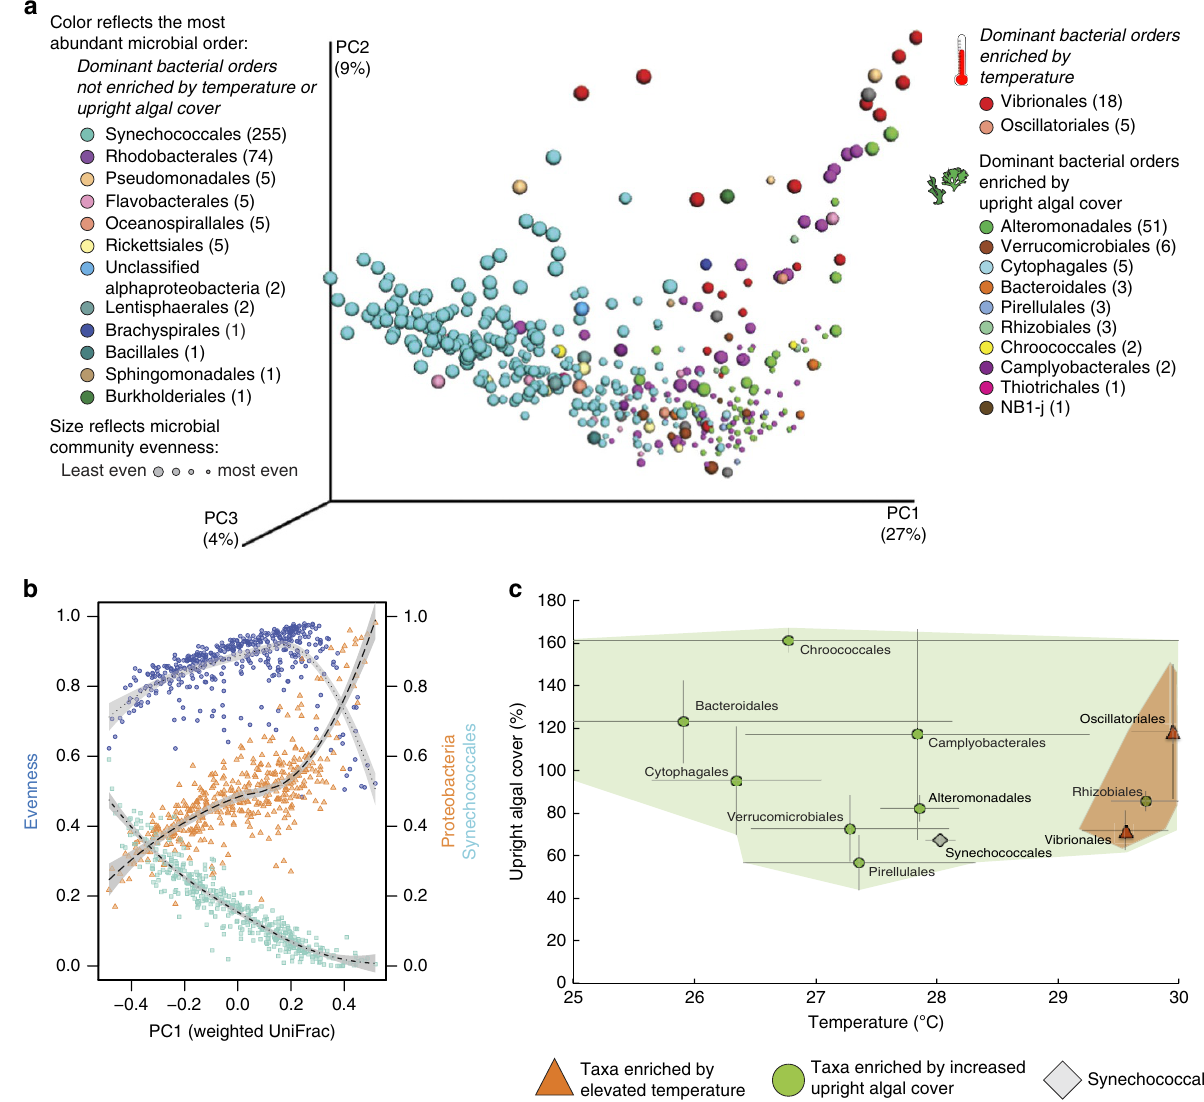
Figure 2 | Algal competition and temperature combine to alter coral microbiomes by driving bacterial blooms. ( a ) Principle coordinates analysis plot, summarizing weighted UniFrac distances between coral microbial samples ( n ¼ 435). The main pattern we seek to show here is a shift from Synechococcus- dominated communities (cyan) to dominance by a wide variety of other orders as one moves from left to right along PC1. Points are coloured to reflect the most dominant (numerically abundant) microbial order in each sample. Sizes reflect quartiles of microbial community evenness (measured by equitability). Orders that were significantly enriched by temperature or upright algal cover (Pearson regression, FDR q o 0.05, Supplementary Table Data 3f and 3g) are grouped together in the legend. Parentheses next to each order note the number of samples, in which that order was dominant. Orders that were dominant in Z 15 samples are marked in bold. ( b ) Displacement of Synechococcales by varied Proteobacteria structured differences between stressed coral microbiomes. Points plot the 1st PC axis ( a ) against the relative abundance of Synechococcales (cyan squares, dot-dashed line), Proteobacteria (orange triangles, dashed line) and overall microbial community evenness (blue circles, dotted line). Lines show local regression (Loess regression, span ¼ 0.75), with grey bars shading extending to twice the s.e. of the regression. ( c ) Combinations of algal cover (macroalgae, cyanobacteria and tall turf algae) and naturally occurring seawater temperature that allowed algae- or temperature- enriched bacterial orders ( a ) to dominate coral microbiomes. The position of each point, and its associated error bars, represents mean algal cover and temperature, and their s.e.’s, for all samples that were dominated by the labelled bacterial order. Synechococcales, which dominated most (258/435) coral microbiome samples, are included as a reference. Taxa dominating Z 15 samples are marked in bold. Coloured polygons enclose suites of taxa whose mean abundance increased with temperature (orange) or upright algal cover (green; Supplementary Data 3 sheets f–h). Vibrionales and Oscillatoriales responded to both temperature and algal cover, but for Vibrionales only temperature was